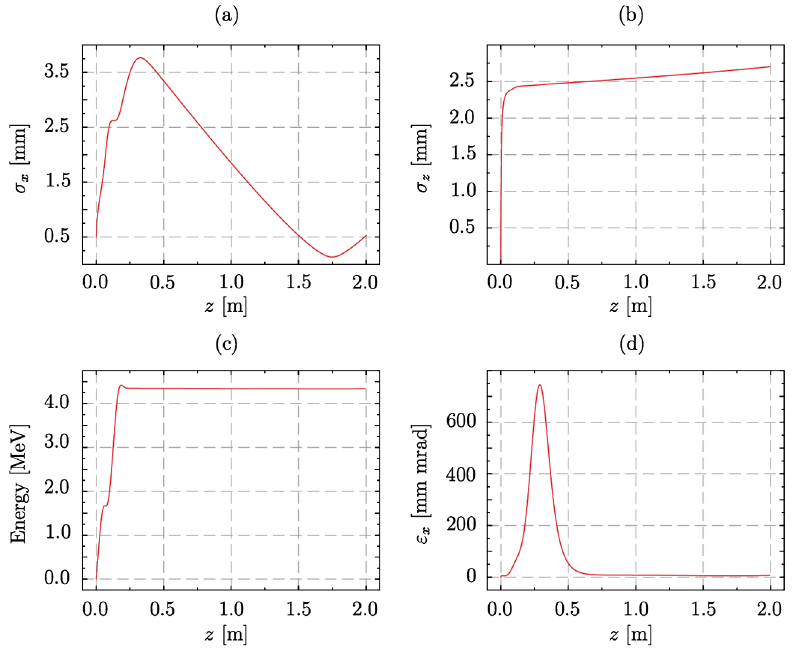
FIG. 13. The plots show the evolution of the RMS bunch width (a), RMS bunch length (b), average particle energy (c), and horizontal emittance (d) along the longitudinal coordinate of the PITZ rf gun.